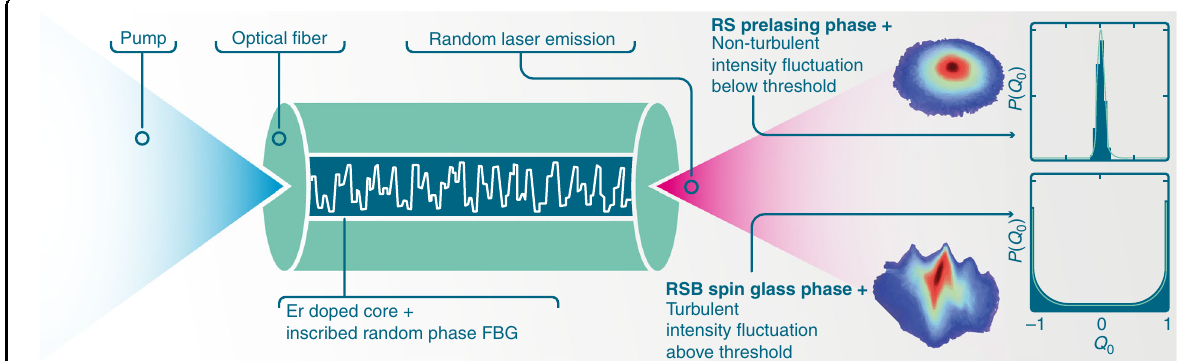
Fig. 1 Schematic erbium-based RFL with random fi ber Bragg gratings. Below threshold, a single central maximum in the distribution P ð Q τ Þ for τ = 0 of the Parisi replica overlap parameter indicates a replica-symmetric (RS) regime with non-turbulent behavior identi fi ed by a Gaussian P ð x τ Þ for τ = 1. Above threshold, P ð Q τ Þ for τ = 0 displays two side maxima demonstrating the presence of a RSB spin glass phase simultaneous with turbulent- like behavior in which P ð x τ Þ for τ = 1 is a heavy-tailed distribution of asymptotic stretched-exponential form. Intermittency effects fade away either below threshold or for τ (cid:3) 1, as rare events in P ð Q τ Þ at much shorter time scales become quite more likely for larger τ (Adapted from 4